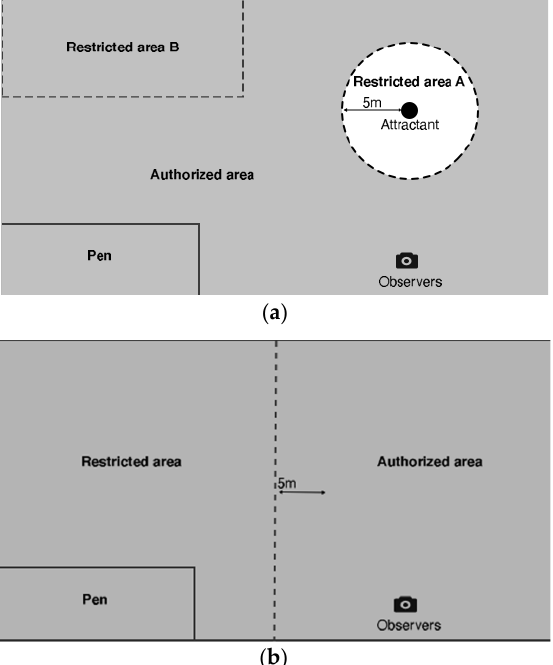
Figure 1: Experimental settings, where both layouts were surrounded by physical fences. (a) Exper- imental layout used in both experiments. The attractant was a bowl filled with. A sound was emitted as soon as the animals were 5 m away from the bowl. ( b ) Experimental layout only used in experi- ment 2. The pasture was divided into two areas (authorized and restricted). The dashed line repre- sents the end of the authorized area. The sound was emitted as soon as the animals were within 5 m of the dashed line.